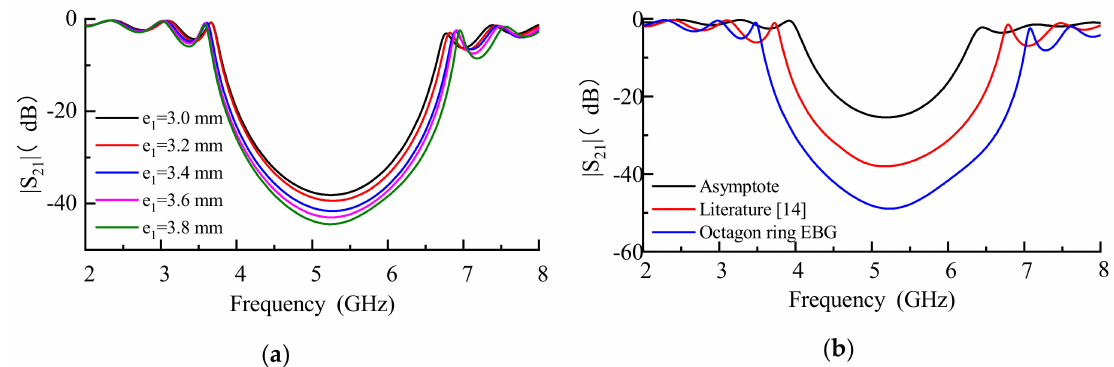
Figure 14. ( a ) Simulation results with di ff erent e 1 using HFSS; ( b ) comparison between the filter in Reference [14] and the filter etched with octagon ring.